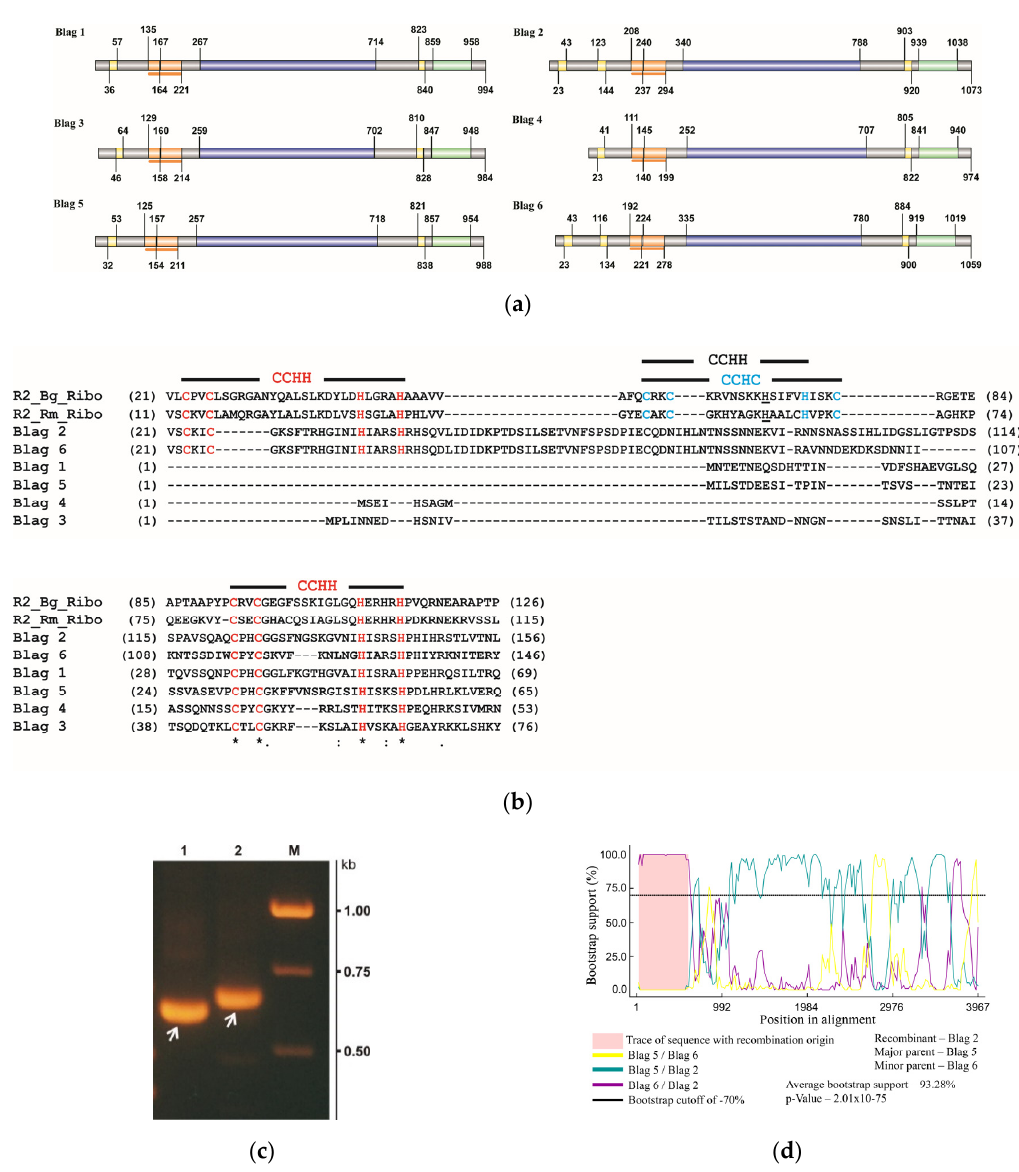
Figure 3. Structural organization of the BLAG retrotransposons of B. germanica . ( a ) Protein domain organization corresponding to the open reading frames (ORFs) of the BLAG retrotransposons of B. germanica . The yellow blocks are zinc-finger domains, the brown block is the BLAG domain, the blue block is the reverse transcriptase domain, and the green block is the endonuclease-like domain. The numbers indicate the positions of the beginning and the end of the corresponding domain. ( b ) The alignment of N-terminal zinc-finger motifs: R2_Bg_Ribo–R2 retrotransposon of B. germanica , R2_Rm_Ribo–R2 retrotransposon of R. maderae , Blag 1–Blag 6—the respective BLAG retrotransposons. The CCHH type of the zinc-finger motifs is shown in red font, and the CCHC type is shown in blue. The CCHH type of the zinc-finger motif is shown in black—see explanation in the text. ( c ) The result of 1% agarose gel electrophoresis to separate the amplification products obtained using a primer located in the region of maximum sequence similarity between the BLAG 2 and BLAG 6 retrotransposons and two other primers located within the unique parts of the sequences of these transposable elements (TEs). Tracks: 1 –BLAG 6, 2 –BLAG 2. Arrows indicate the amplification products used for cloning and sequencing. ( d ) BOOTSCAN plots of the recombination event detected by using RDP4 software. The bootstrap support for each pair of sequences is plotted on the y -axis, and their position in the alignment is plotted on the x -axis. The recombinant region is shown in pink. Symbols are listed in the